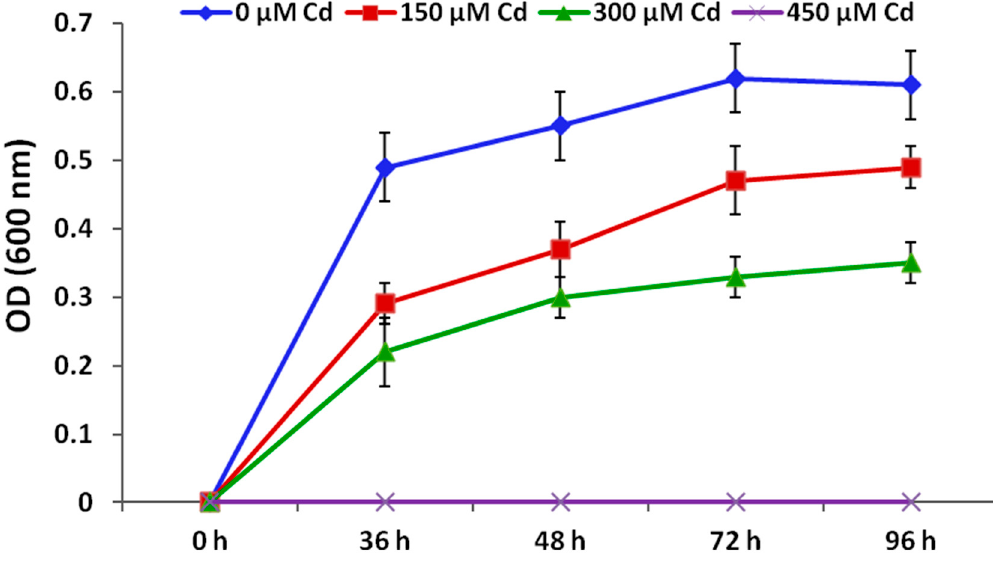
Figure 1. Growth curve of Serratia marcescens BM1 in nutrient broth media supplemented with 0, 150, 300, and 450 µM CdCl 2 after 0, 36, 48, 72, and 96 h of incubation at 29 °C.